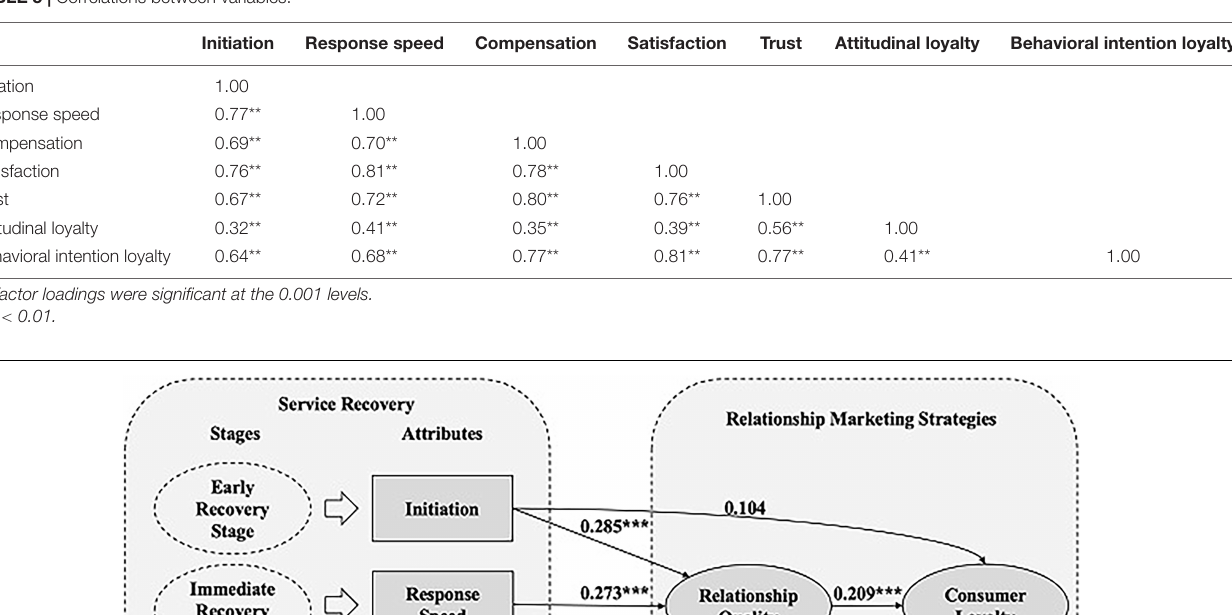
TABLE 5 | Correlations between variables.